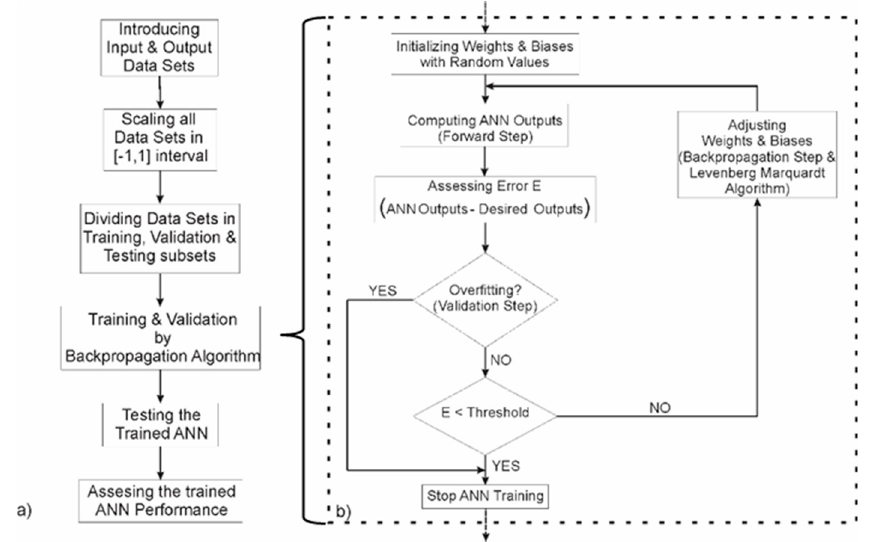
Figure 1. ( a ) Flowchart of the computation, ( b ) Flowchart of the backpropagation algorithm.